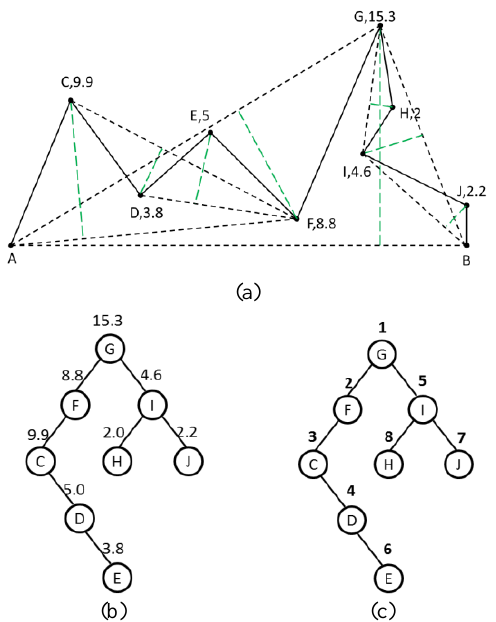
Figure 1. An example of the BLG tree and its ranking